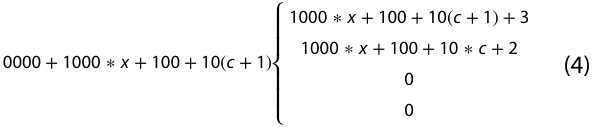
Fig. 11 Illustration of the Joint-X joints when y = 1